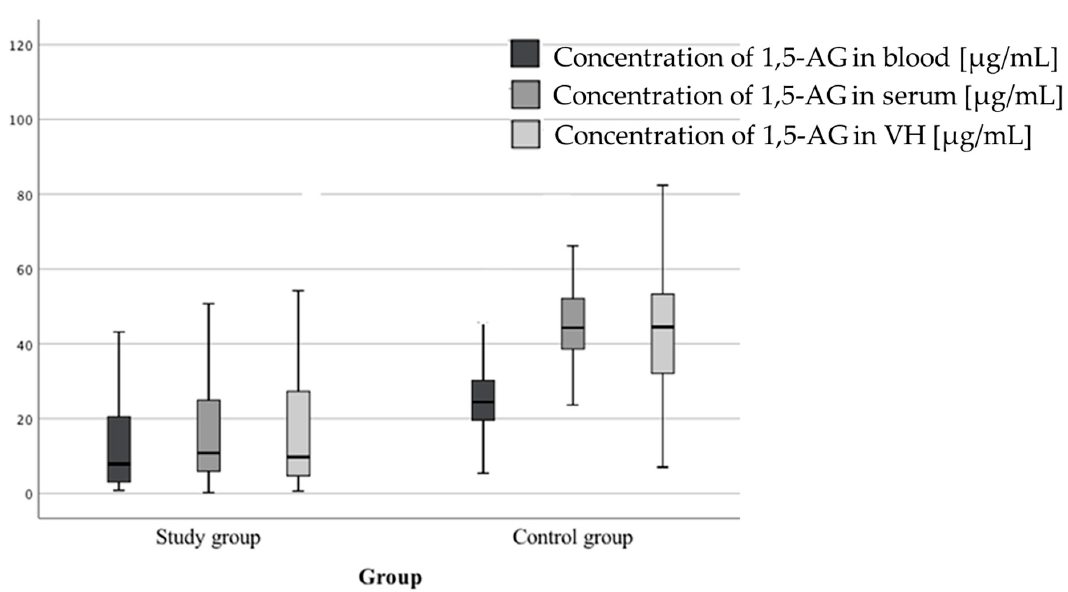
Figure 3. Comparison of 1,5-anhydroglucitol (1,5-AG) concentrations in different biological materials for both study and control groups.